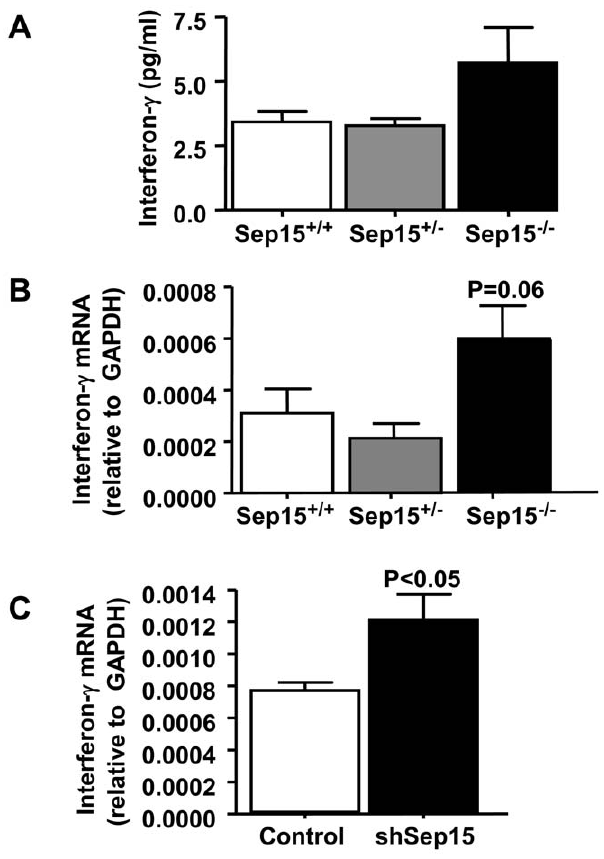
Figure 6. Interferon- c levels. (A) Interferon- c levels in serum of Sep15 knockout mice (Sep15 2 / 2 ) compared to heterozygous (Sep15 + / 2 ) and wild type (Sep15 + / + ) litter mate controls (N=5 per genotype) on 0.1 m g selenium/g diet as measured by ELISA. (B) Interferon- c levels in colonic epithelia of Sep15 2 / 2 mice compared to Sep15 + / 2 and Sep15 + / + litter mate controls (N=5 per genotype) on 0.1 m g selenium/g diet as measured by quantitative real-time PCR. (C) Interferon- c mRNA levels in murine colon cancer CT26 cells with targeted down-regulation of Sep15 (shSep15) compared to plasmid-transfected control cells as measured by real time RT-PCR.